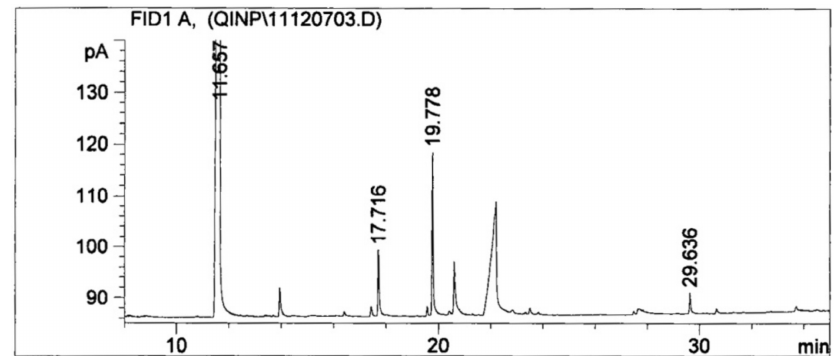
Figure 6. Sample organic acid methyl ester by gas